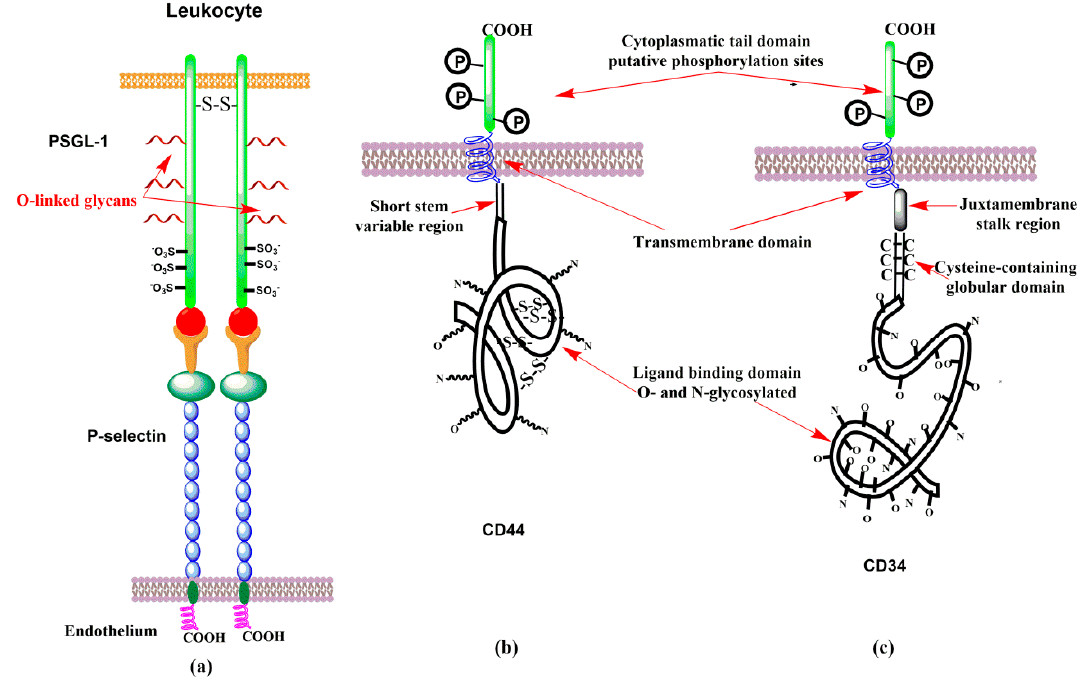
Figure 5. Schematic representation of ( a ) interactions of PSGL-1 homodimer with P-selectin, ( b ) CD44 glycoform, and ( c ) CD34 glycoform.